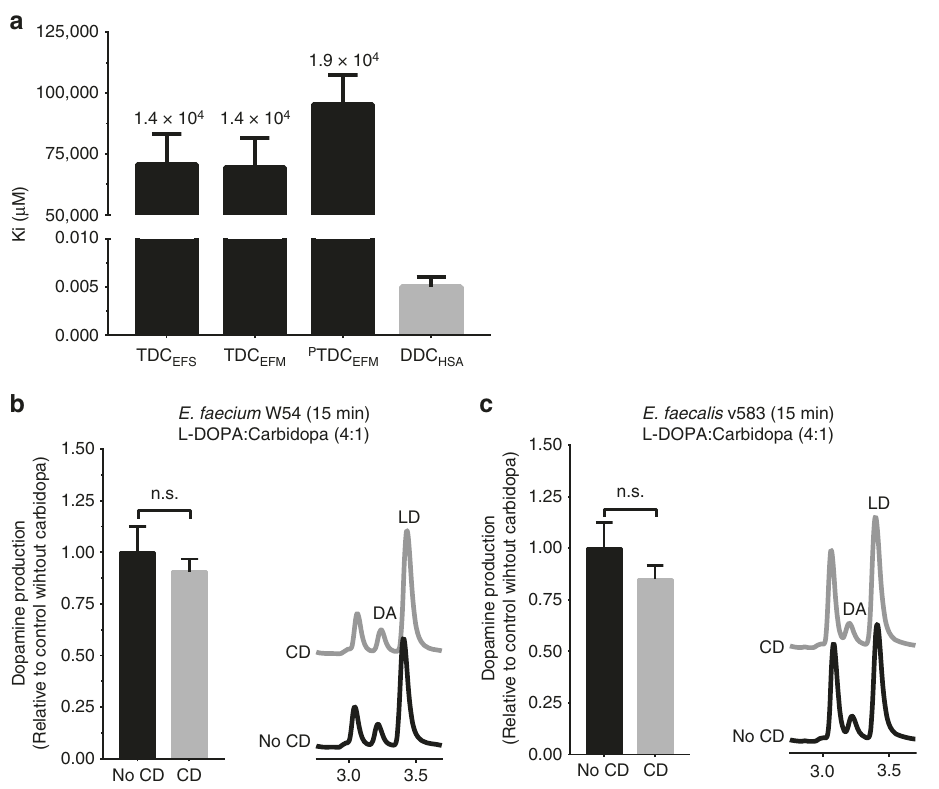
Fig. 4 Human DOPA decarboxylase inhibitor, carbidopa, does not inhibit bacterial tyrosine decarboxylases. a Inhibitory constants (Ki) of bacterial decarboxylases (black) and human DOPA decarboxylase (gray), with fold-difference between bacterial and human decarboxylase displayed on top of the bars. Quantitative comparison of dopamine (DA) production by E. faecium W54, b and E. faecalis v583, c at stationary phase after 15 min, with representative HPLC-ED curve. Bacterial cultures ( n = 3) were incubated with 100 µ M levodopa (LD) or a 4:1 mixture (in weight) of levodopa and carbidopa (CD) (100 µ M levodopa and 21.7 µ M carbidopa). Error bars represent SEM ( a ) or SD ( b , c ) and signi fi cance was tested using a parametric unpaired T -test